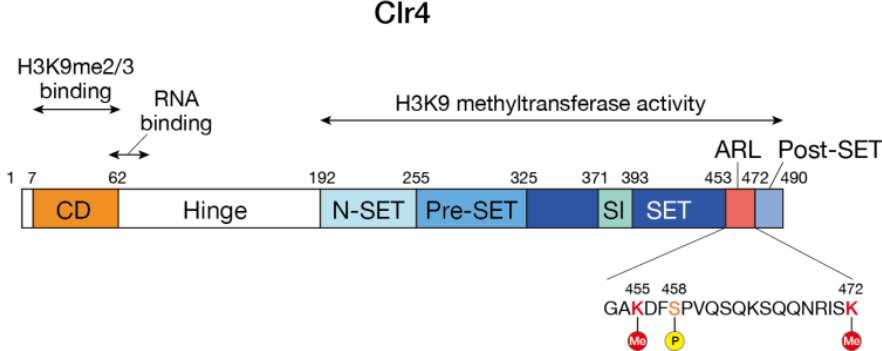
Figure 1. Domain organization of S. pombe Clr4 and the positions of automethylated lysine (K455 and K472) and serine (S458) phosphorylated by Cdk1. ARL, autoregulatory loop; CD, chromodomain; SI, SET insertion domain.